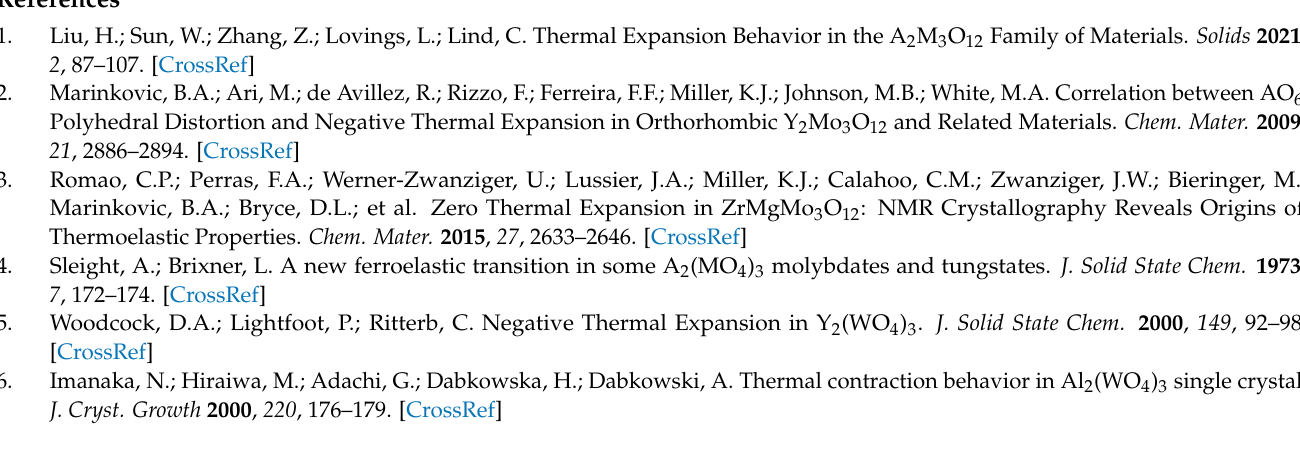
x = 1 phase, from RT to 400 ◦ C, Figure S2-1: Natural logarithmic variations of unit-cell parameters (a, b and c) and unit-cell volume vs. temperature for x = 0.2 phase. (d), Figure S2-2: Natural logarithmic variations of unit-cell parameters (a, b and c) and unit-cell volume vs. temperature for x = 0.4 phase (d). Figure S2-3: Natural logarithmic variations of unit-cell parameters (a, b and c) and unit-cell volume vs. temperature for x = 0.7 phase (d), Figure S2-4: Natural logarithmic variations of unit-cell parameters (a, b and c) and unit-cell volume vs. temperature for x = 1 phase (monoclinic form) (d), Figure S2-5: Natural logarithmic variations of unit-cell parameters (a, b and c) and unit-cell volume vs. temperature for x = 1 phase (orthorhombic form) (d), Figure S3: TGA curves of phases in Al 2 − x In x W 3 O 12 system: (a) x = 0.2; (b) x = 0.4; (c) x = 0.7 and (d) x = 1. Table S1: Theoretical, real and relative densities of Al 2 − x In x W 3 O 12 phases with the nominal chemical compositions x = 0.2; x = 0.4; x = 0.7 and x = 1, Table S2: Unit-cell parameters at RT in Al 2 − x In x W 3 O 12